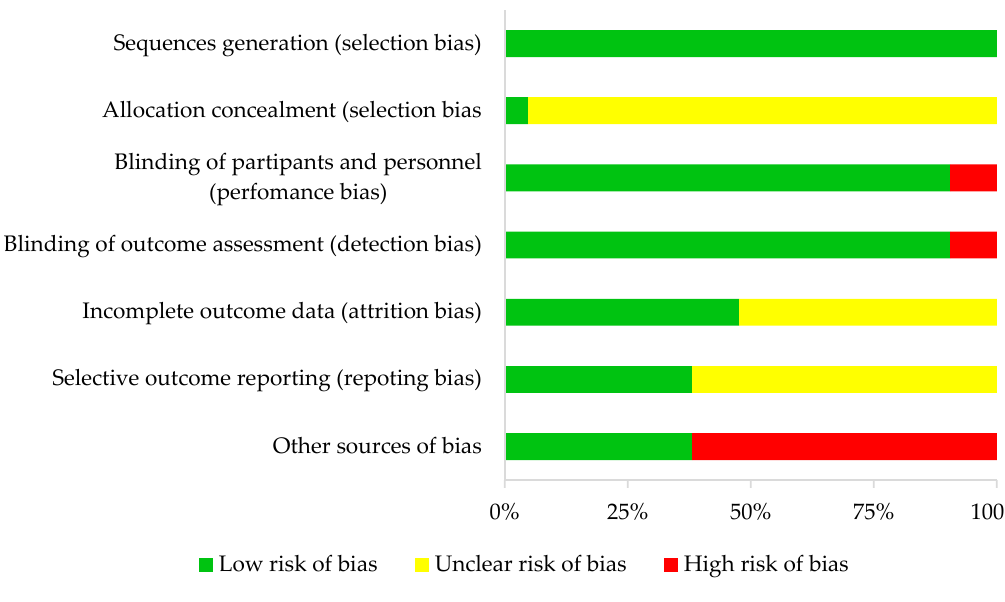
Figure 2. Risk of bias Figure 2 . Risk of bias summary .